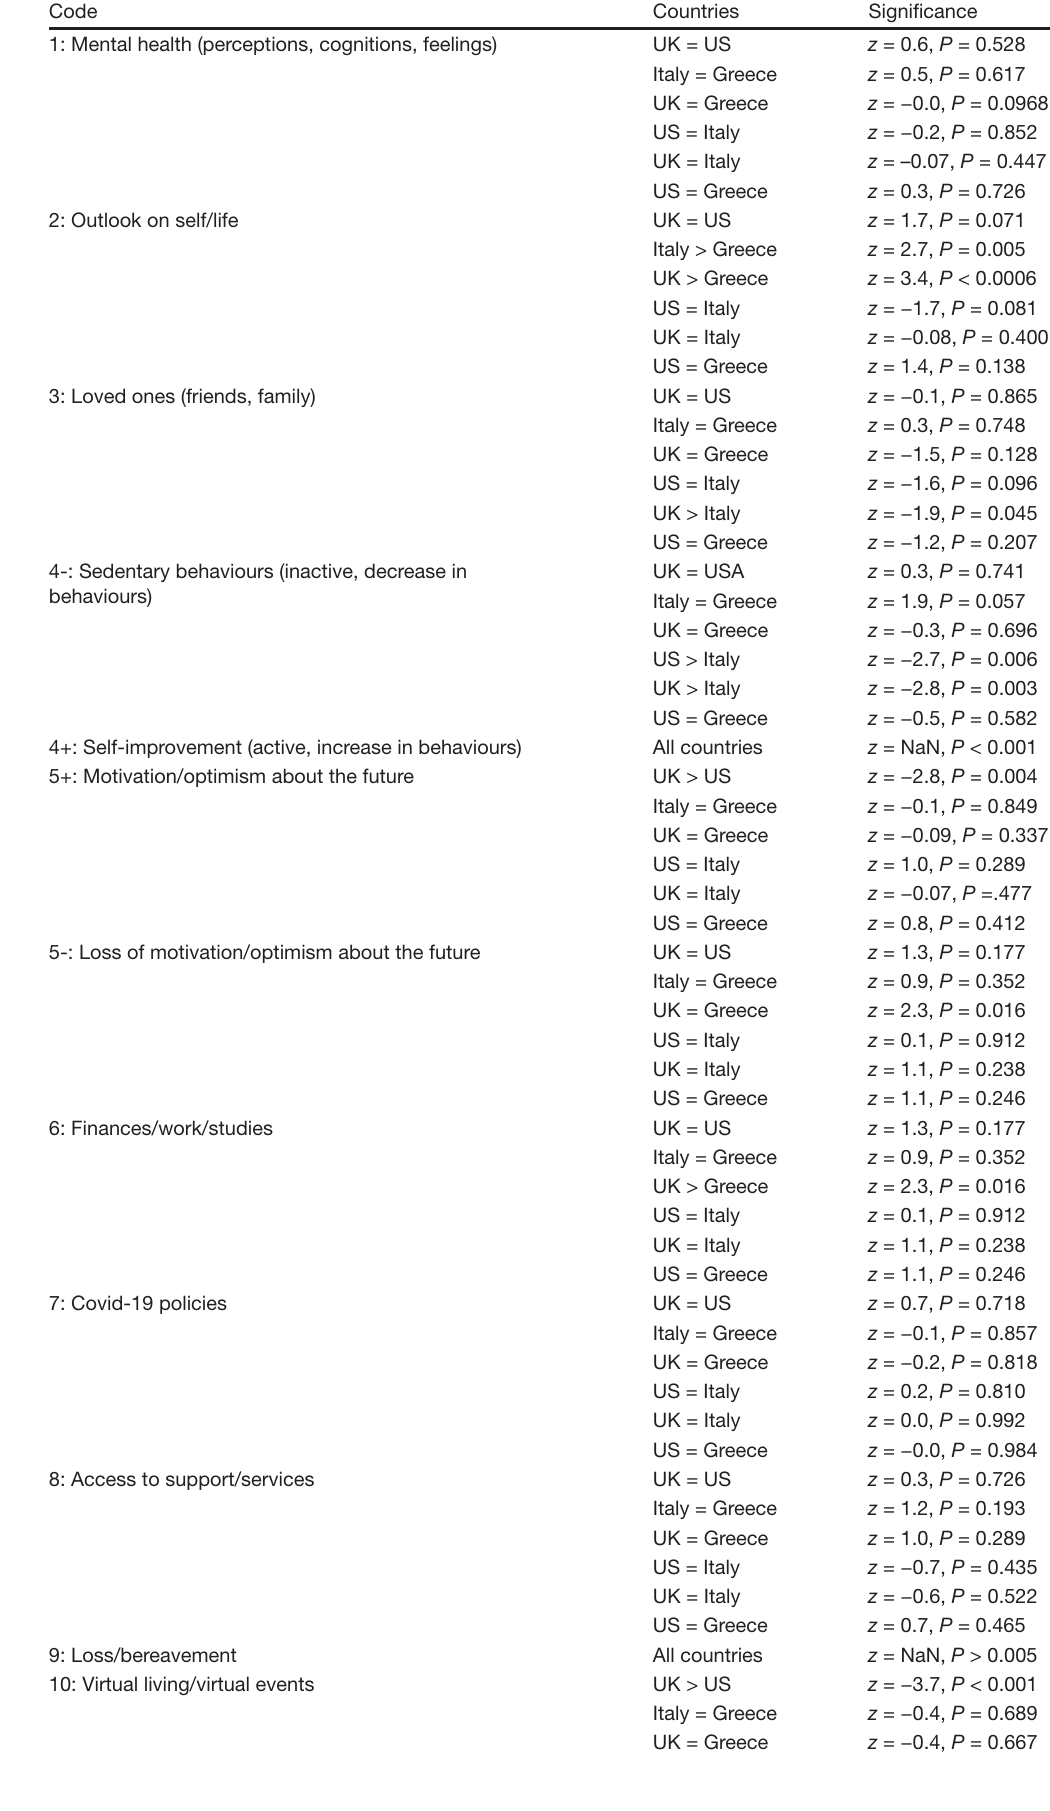
Table 5. Analysis of code frequencies by